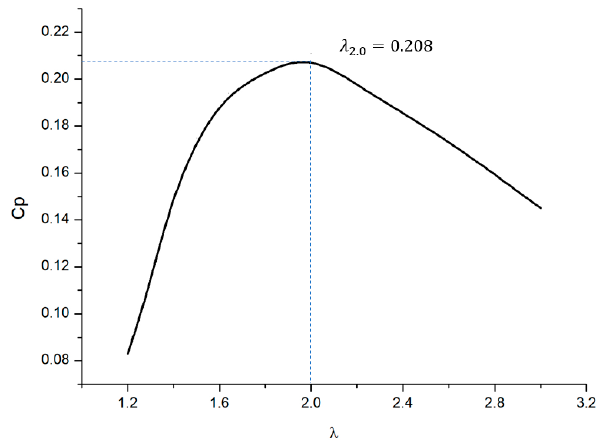
Figure 11. The energy utilization coefficient’s variation with the change in the velocity ratio.